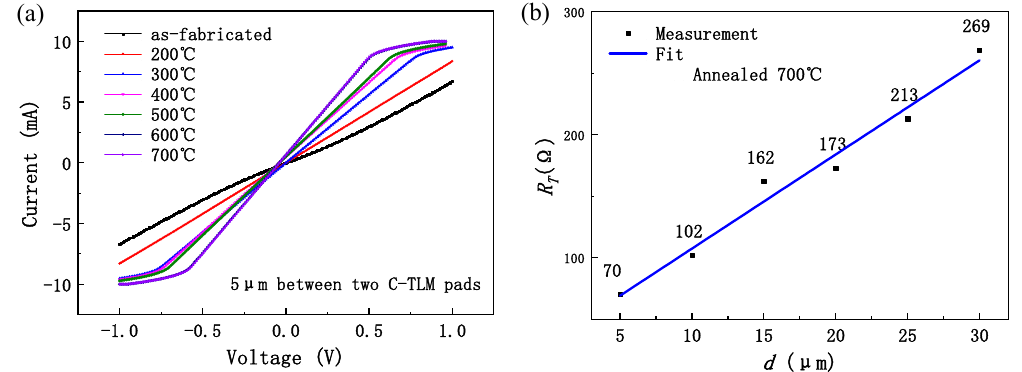
Figure 4. ( a ) I - V characteristics of as-fabricated and annealed Pt / Au / H-SCD with the same C-TLM pattern, ( b ) Linear fitting diagram for the Pt / Au / H-SCD contact at 700 ◦ C annealing.